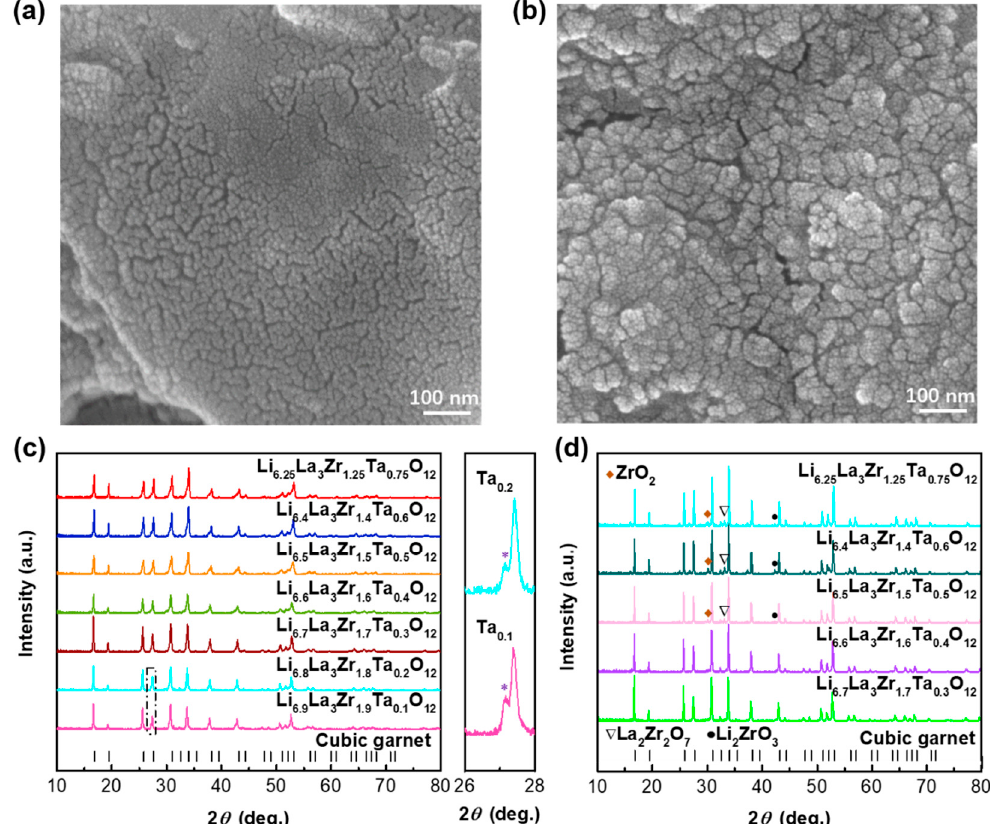
Figure 1. SEM of LLZTO calcined at 900 °C with GO ( a ) and without GO ( b ). The XRD results of the Ta ‐ doping and Ta/Mg ‐ dual substituted garnet calcined at 900 °C ( c ) and sintered at 1100 °C ( d ). The black vertical lines at the bottom represent the reference cubic garnet (PDF#45 ‐ 0109).